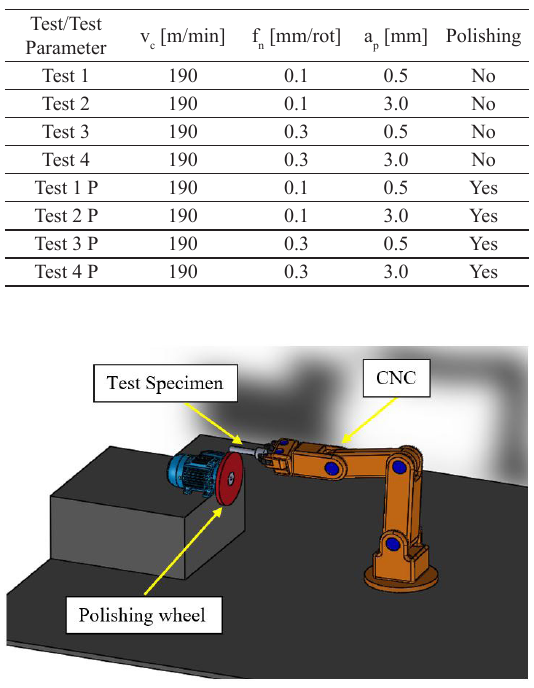
Figure 1. Sample polishing